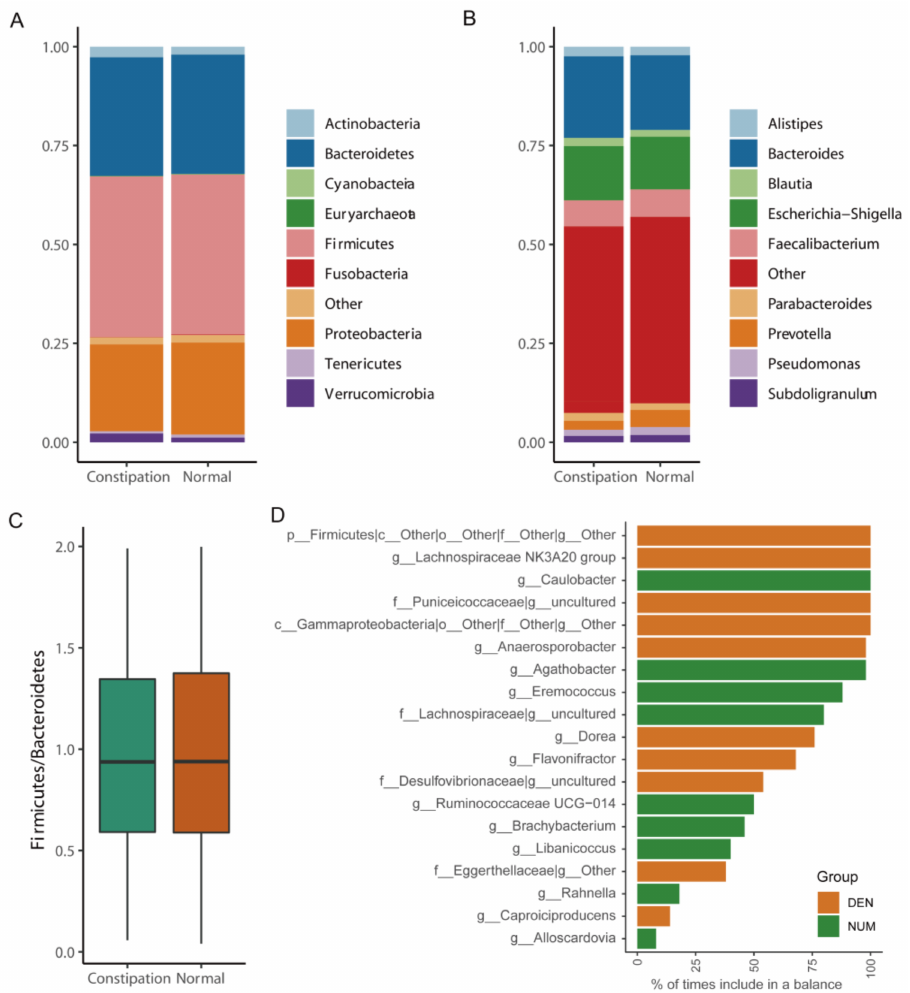
Figure 4. Differences in the gut microbiome composition at the phylum level ( A ) and genus level ( B ) between patients with constipation and healthy controls. The Firmicutes:Bacteroidetes ratio of the gut microbiome did not differ significantly between the two groups ( C ). The balance selected genera that significantly differed between the two groups ( D